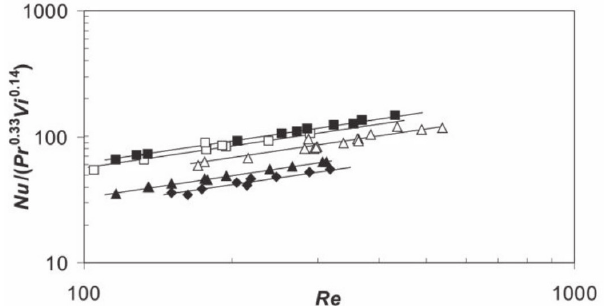
Fig. 7 – The dependence Nu/(Pr 0.33 Vi 0.14 ) = f(Re) for glycerol (w = 0 m s –1 ) and different positions of the dimensionless axi­ og al coordinate z/H; lower impeller – A 315, upper impeller – RT,  – z/H= 0.07; D – z/H = 0.16;  – z/H = 0.42;  – z/H = 0.67; ▲– z/H = 0.82; experimental points obtained using ther­ mal method